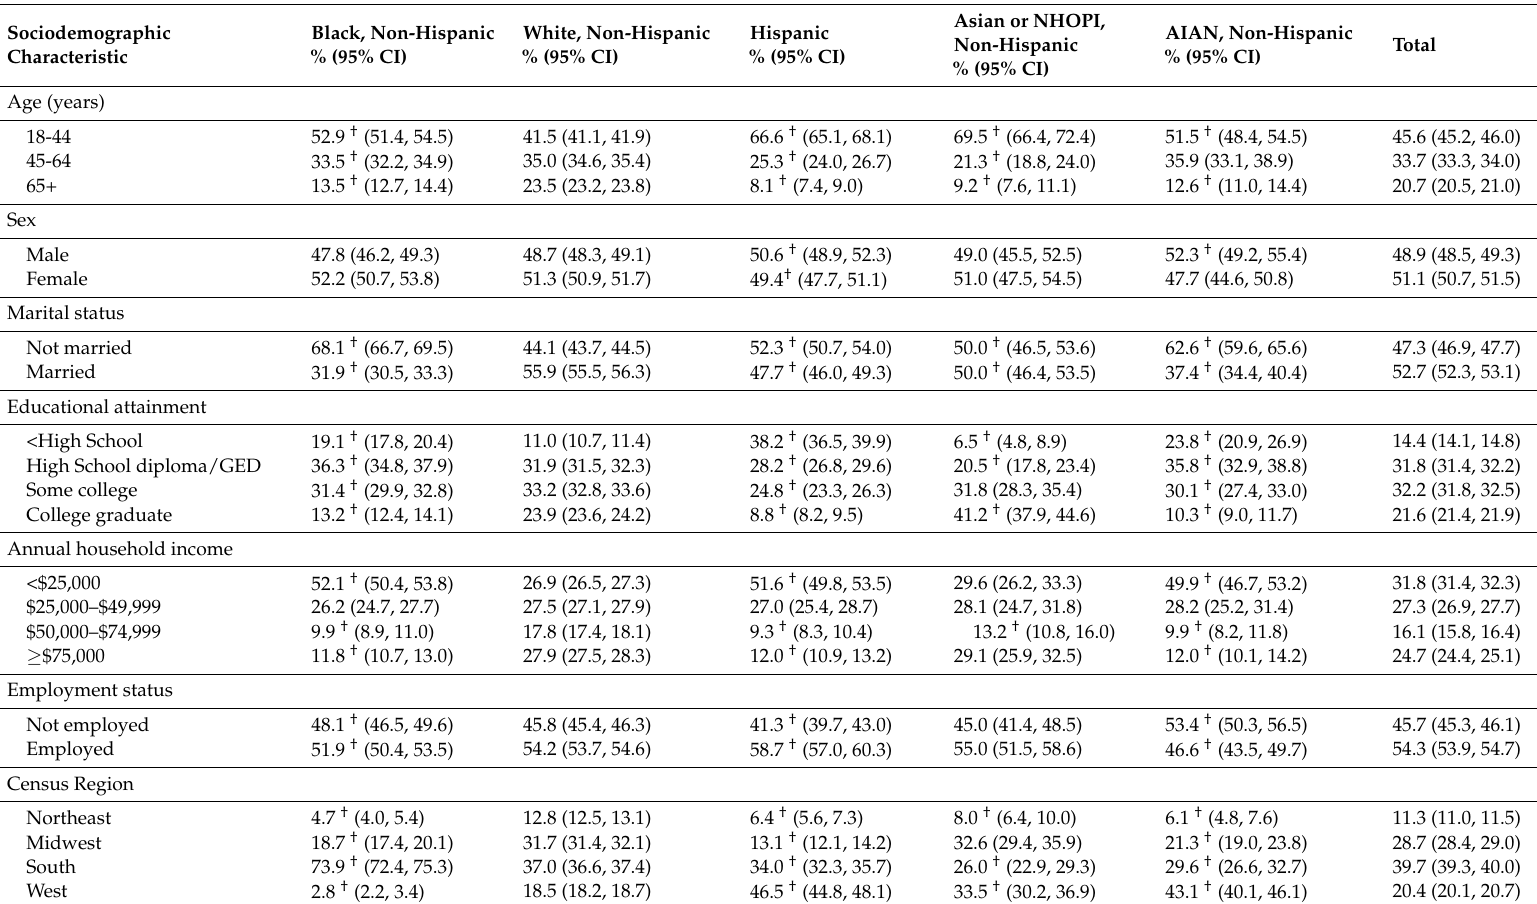
Table 3. Sociodemographic characteristics of small metropolitan dwelling adults * by race and ethnicity: Behavioral Risk Factor Surveillance System, United States,